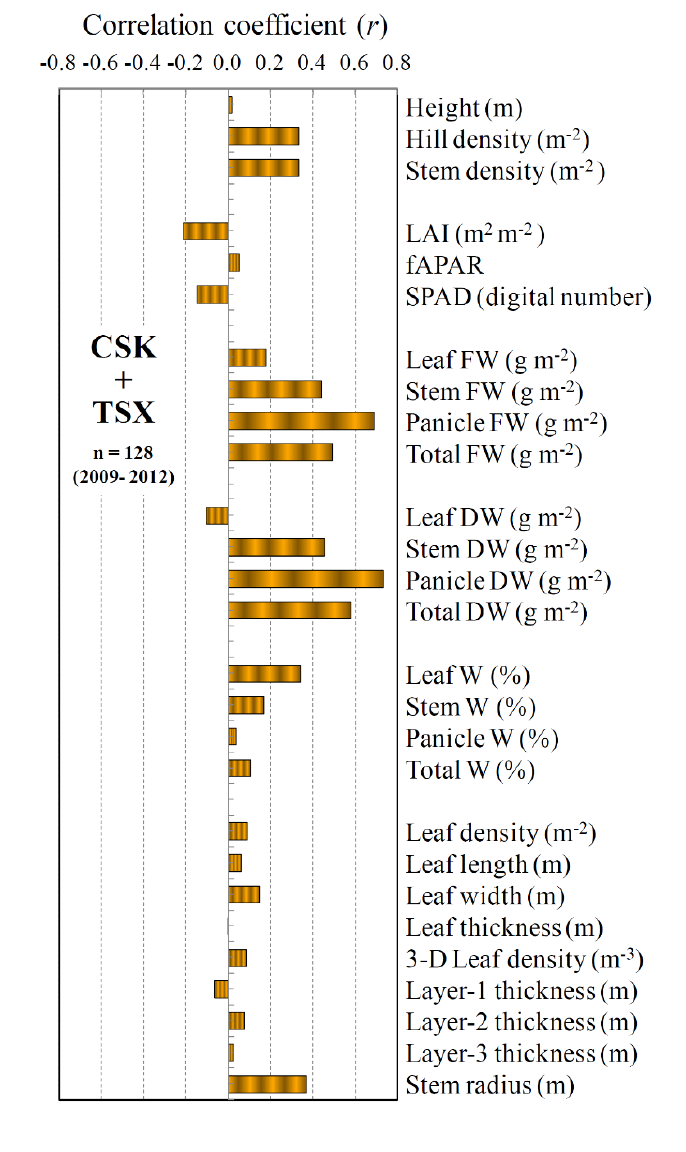
Figure 6. Correlation of σ 0 with biophysical and morphological variables in rice canopies at maturing stage using the combined CSK + TSX dataset after offset correction. Abbreviations are the same as in Figure 5. The correlation coefficients ( r ) at significance levels of 0.01 and 0.05 are 0.25 and 0.19,